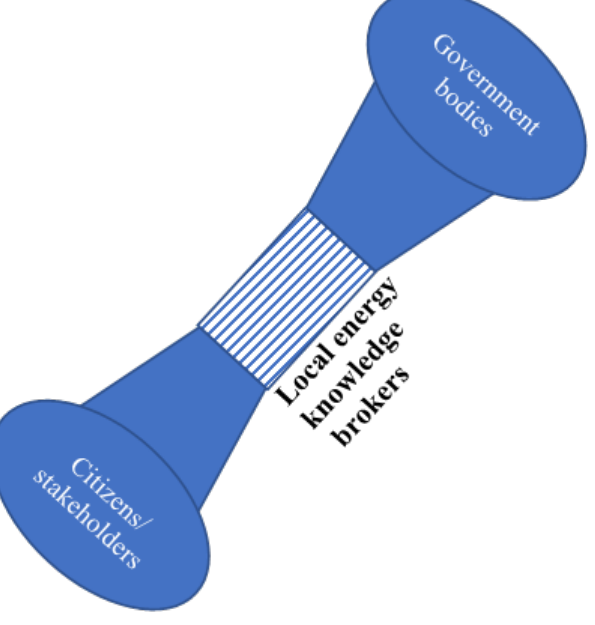
Figure 7. The “diabolo model” for citizen participation in local energy transition planning.